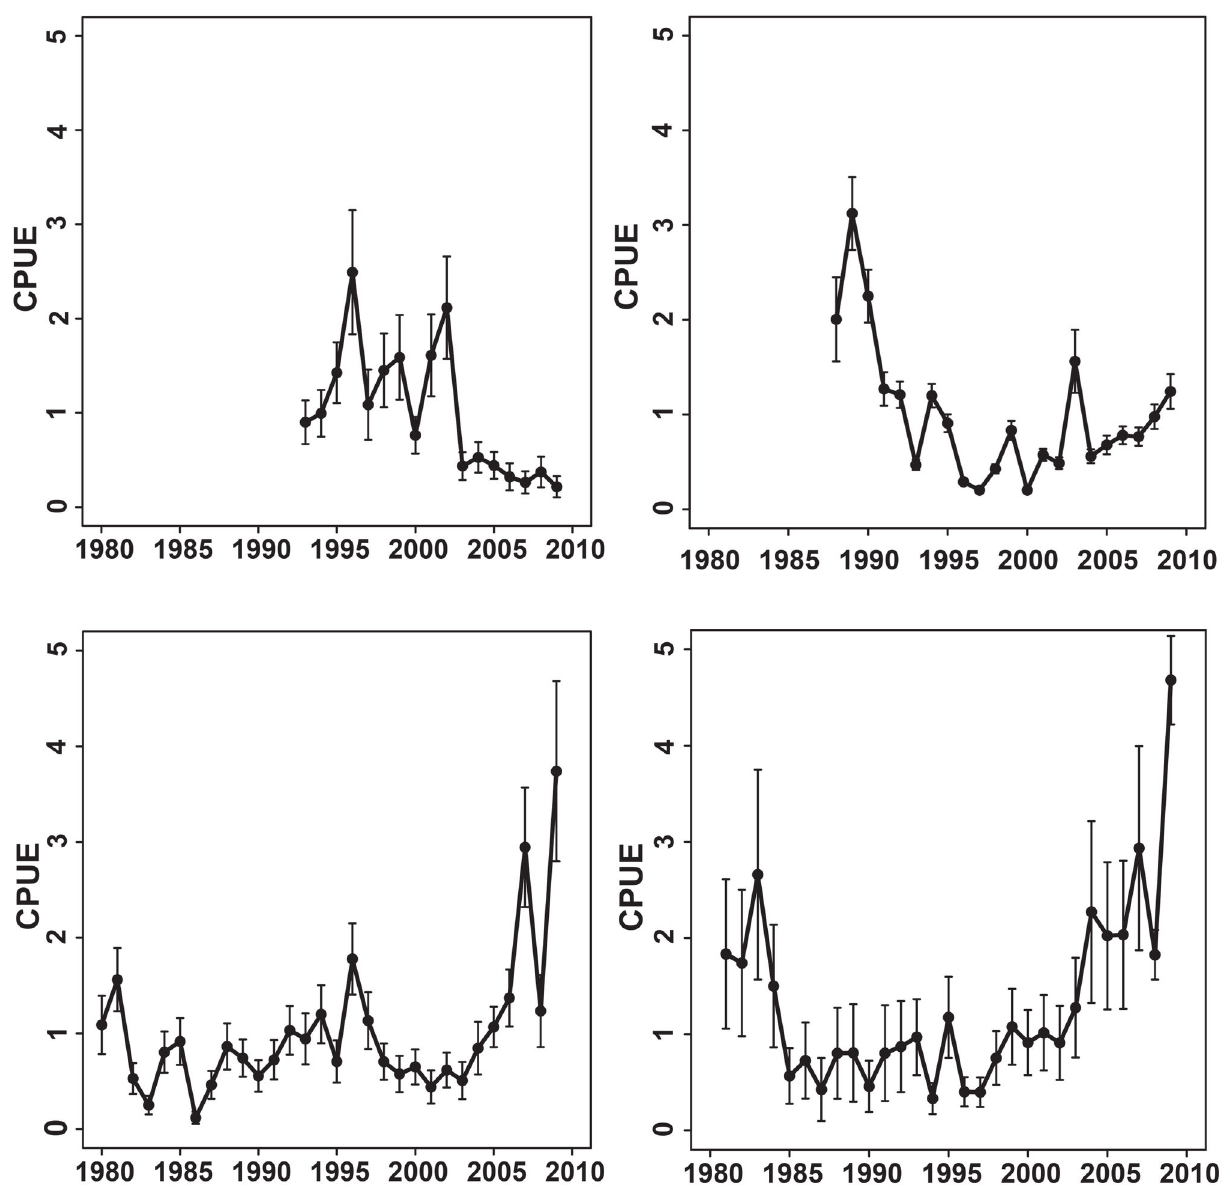
Figure 5. Catch per unit effort (CPUE) for Atlantic bluefin tuna calculated across four regions of the northwest Atlantic shelf. (A) The Gulf of Maine CPUE has been in decline since 1996. Adjacent shelf regions such as (B) southwest Nova Scotia, (C) the offshore northwest Atlantic area two, and (D) the Gulf of St. Lawrence all show increasing catch per unit effort during periods of decline in Gulf of